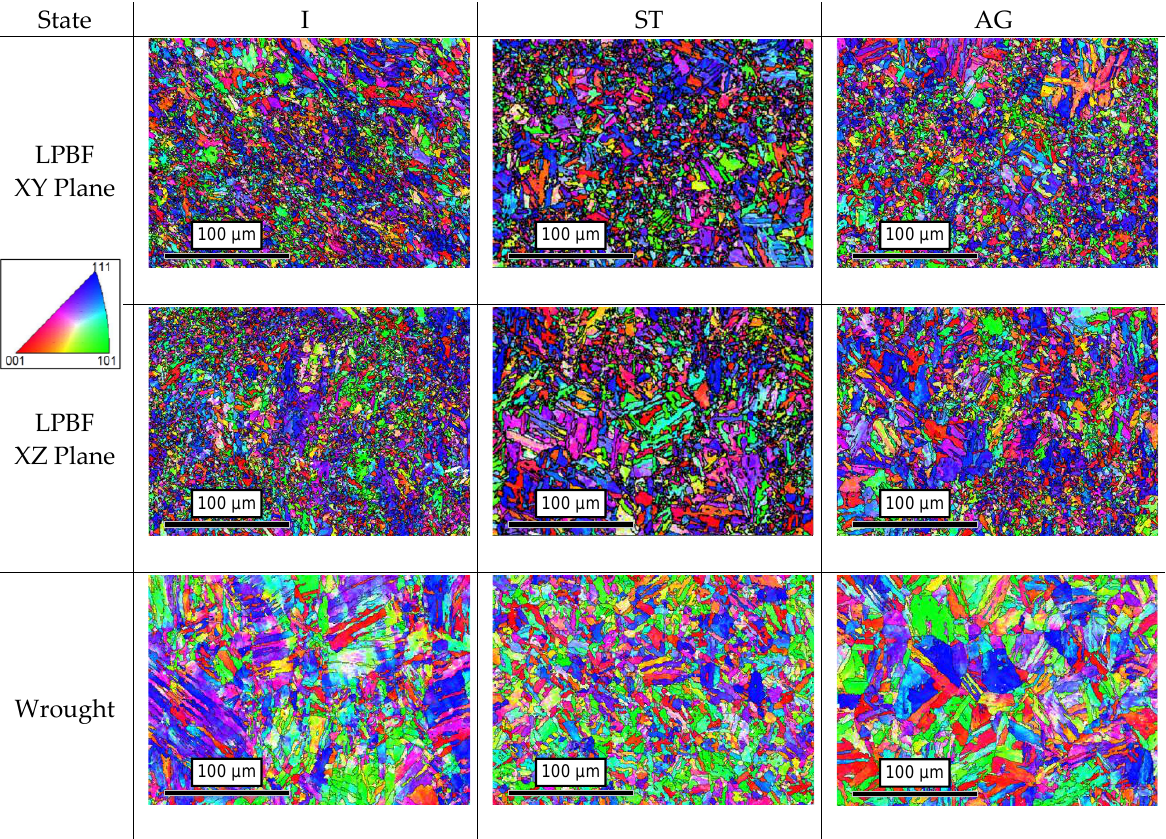
Figure 10. EBSD IPF maps of the LPBF and wrought alloys in the initial, solution-treated, and aged states; color crystalline orientation code is inserted.